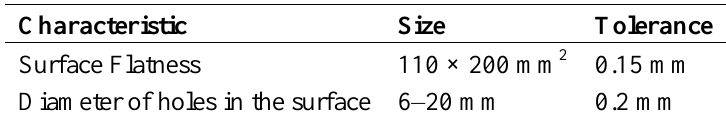
Table 1. Specifications of the